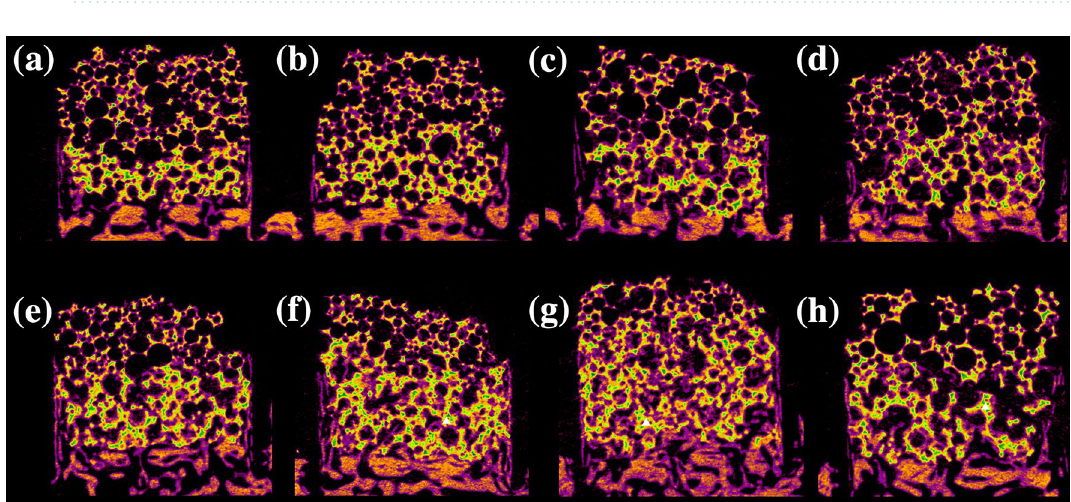
Figure 2. Radiological analysis of new bone formation in response to HA/TCP scaffolds in New Zealand white rabbits 8 weeks post-operation.; ( a ) 0.1 mg/mL PDRN; ( b ) 1.0 mg/mL PDRN; ( c ) 5 mg/mL PDRN; ( d ) 10 mg/ mL PDRN; ( e ) 0.01 mg/mL rhBMP-2; ( f ) 0.05 mg/mL rhBMP-2; ( g ) 0.1 mg/mL rhBMP-2; ( h ) Control group; (white triangle) new bone. PDRN polydeoxyribonucleotide; rhBMP-2 recombinant human bone morphogenic protein; HA hydroxyapatite; TCP tricalcium